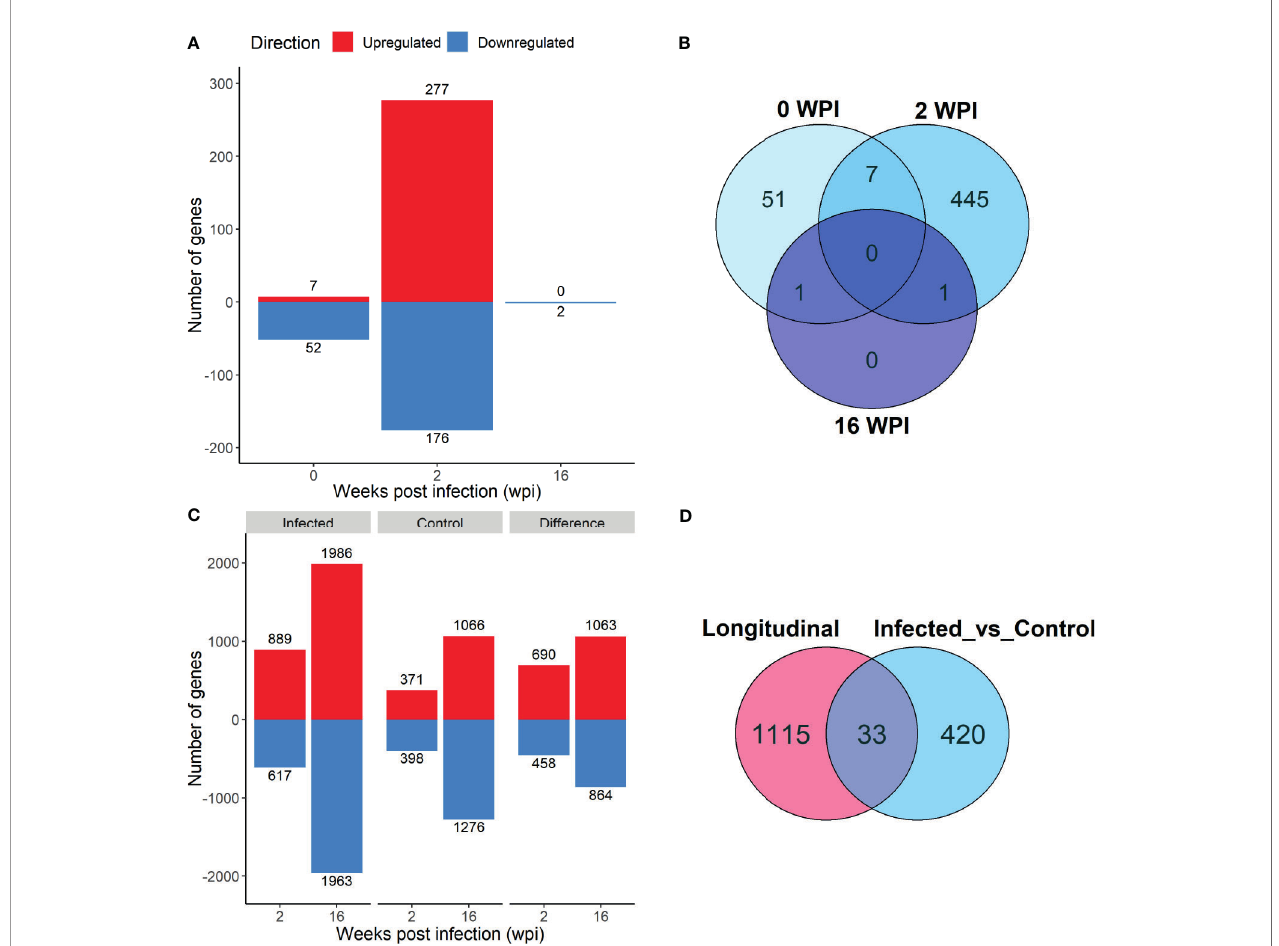
FIGURE 3 | Differentially expressed (DE) genes that were up- (red) and downregulated (blue) in PBMC in response to F. hepatica in the Infected vs Control analysis, with the Benjamini ‐ Hochberg adjusted P value < 0.1 (A) and in the longitudinal analysis, adjusted P ‐ value < 0.05 (C) . Venn diagrams of overlap of genes in the different time points of Infected vs Control analysis (B) and between the Longitudinal and Infected vs Control analysis at 2 wpi (D)